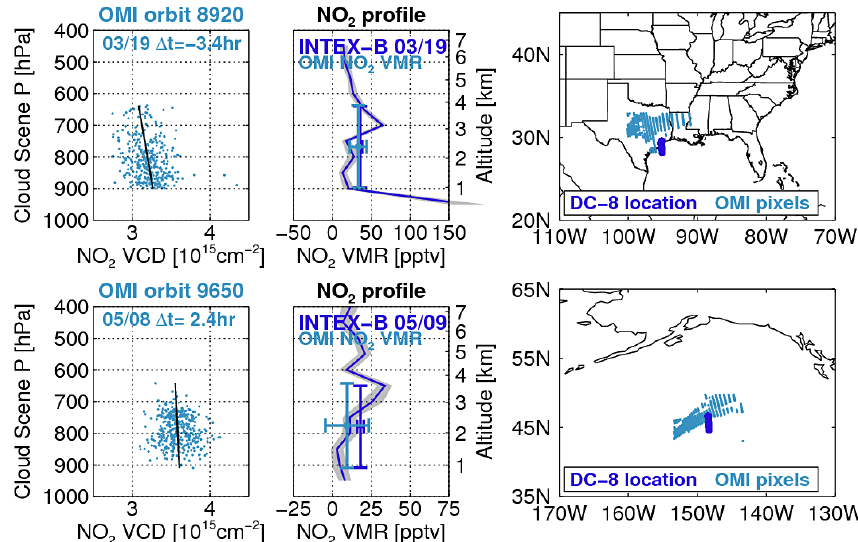
Figure 5. Examples of relatively good agreement between OMI cloud-slicing VMRs and INTEX-B NO 2 profiles near Houston, Texas, US (top row), and the northeastern Pacific (bottom row). In each example, left: OMI above-cloud NO 2 column versus cloud scene pressure (similar to Fig. 1b); center: INTEX-B NO 2 profiles (dark blue line), INTEX-B NO 2 VMR averaged over the OMI pressure range (dark blue square with error bars), and OMI-derived NO 2 VMR (light blue square with error bars); right: locations of OMI and INTEX-B aircraft